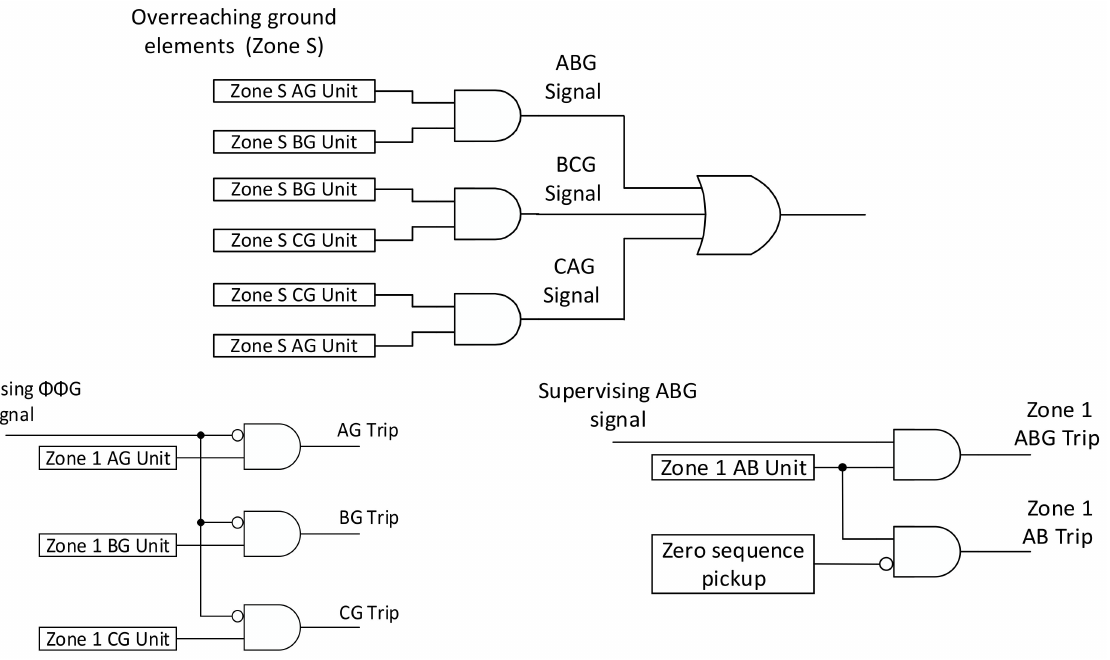
Figure A1. Logic diagram of the implemented impedance-based phase identification technique